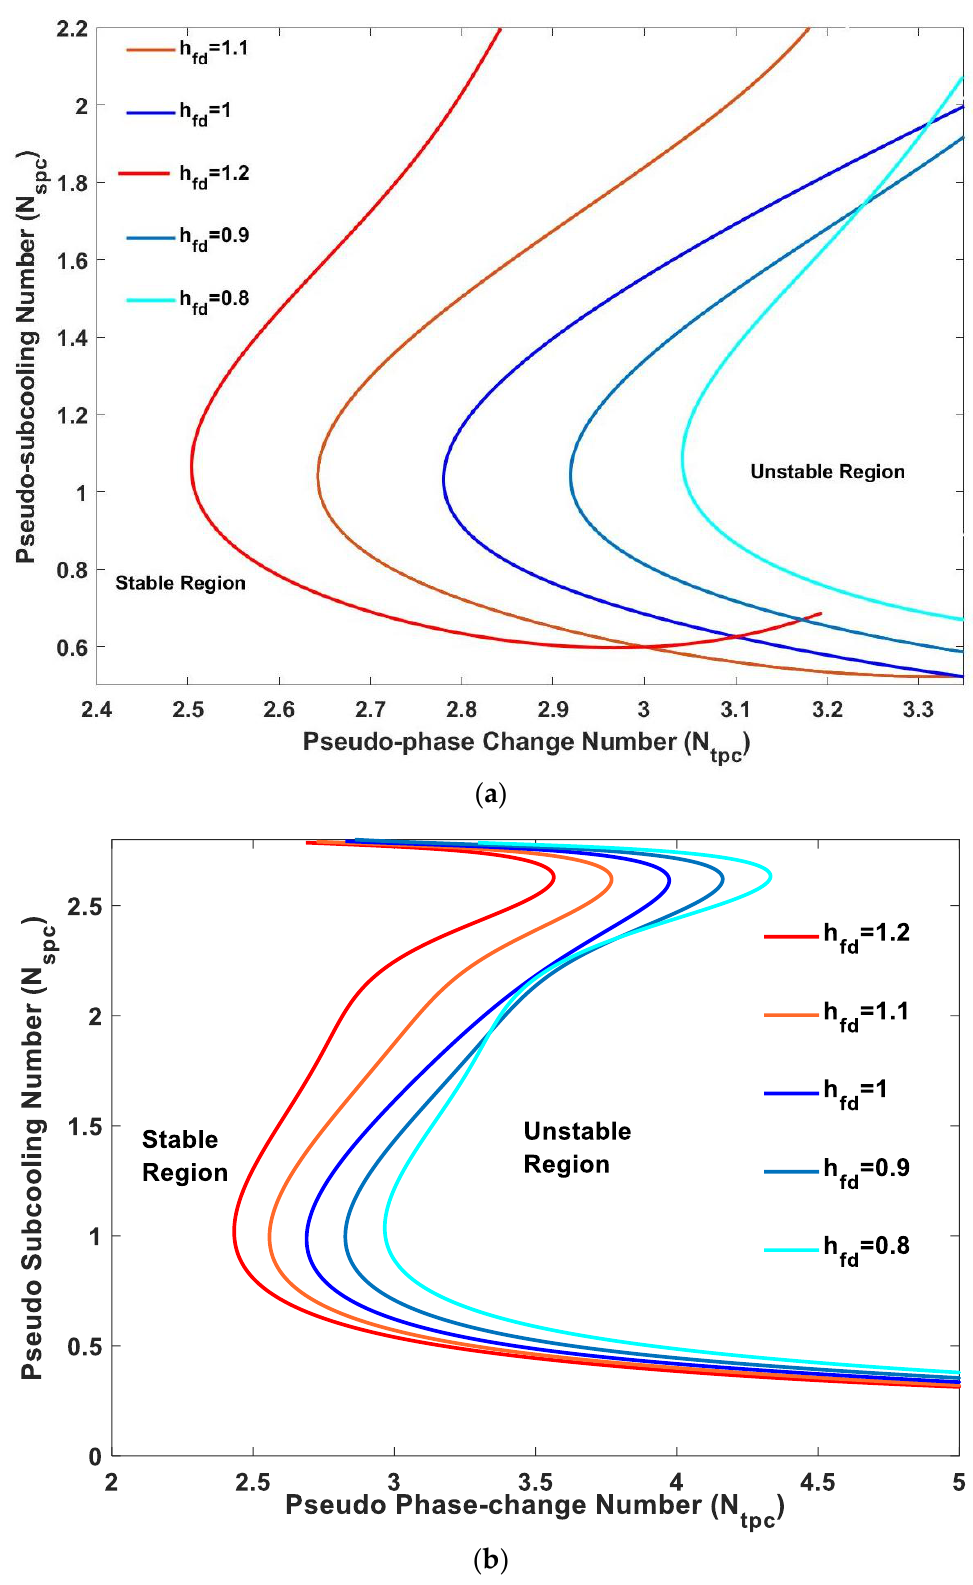
Figure 3. Stability threshold in the N tpc − N spc space at different h fd values. ( a ) Supercritical water (H 2 O) . ( b ) Supercritical carbon dioxide (CO 2 ) .